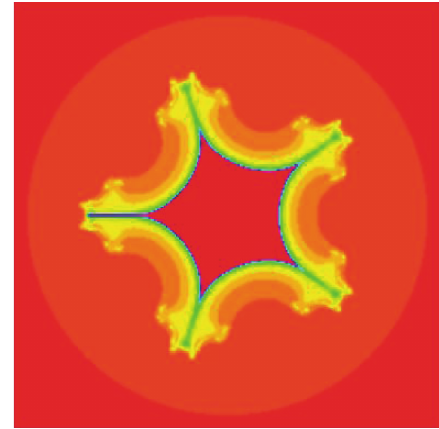
Figure 21: Relative superior multicorn for 𝑠 = 0.6 , 𝑠 󸀠 = 0.5 , and 𝑛 = 8